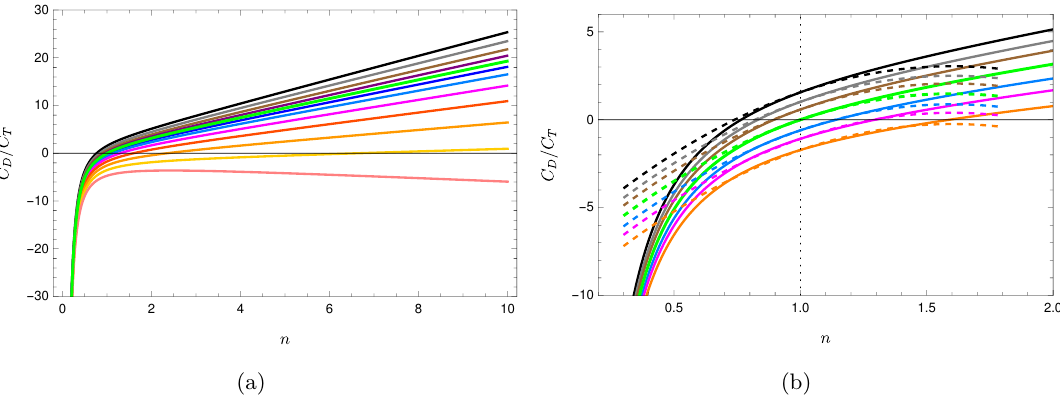
Figure 1 . Plots of C D /C T , defined in eqs. (3.13) and (3.35), as a function of n in d = 3 . The colours correspond to different fixed values of the chemical potential ˜ µ in eq. (3.37) with ‘ different curves correspond to ˜ µ 2 = ± 0 . 04 , ± 0 . 09 , ± 0 . 16 , ± 0 . 25 , 0 . 36 , 0 . 49 , 0 . 64 , with ˜ µ 2 increasing from top to bottom. We highlight in green the curve corresponding to ˜ µ = 0 . Note that ˜ µ 2 can be negative, as the chemical potential can take imaginary values. (b) Zoom of the same plot around the region close to n = 1 . The dashed lines correspond to the analytic expansions in eq. (3.38). Curves with the same colours correspond to the same chemical potential.